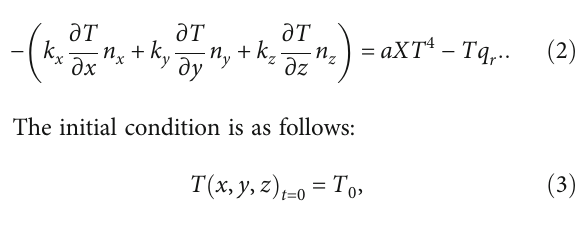
= 900s . (b) t = 1800s 1 2